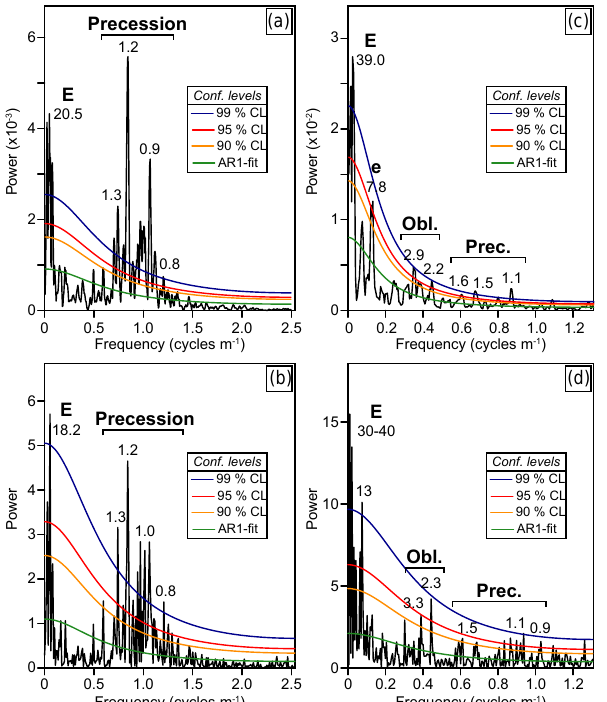
Figure 6. Spectra of the La Charce and La Thure series before Monte Carlo simulations of the sample distances. (a) 2 π -MTM spectrum of the La Charce series. (b) REDFIT spectrum of the La Charce series. (c) 2 π -MTM spectrum of the La Thure series. (d) REDFIT spectrum of the La Thure series. The main significant periods are given in metres.